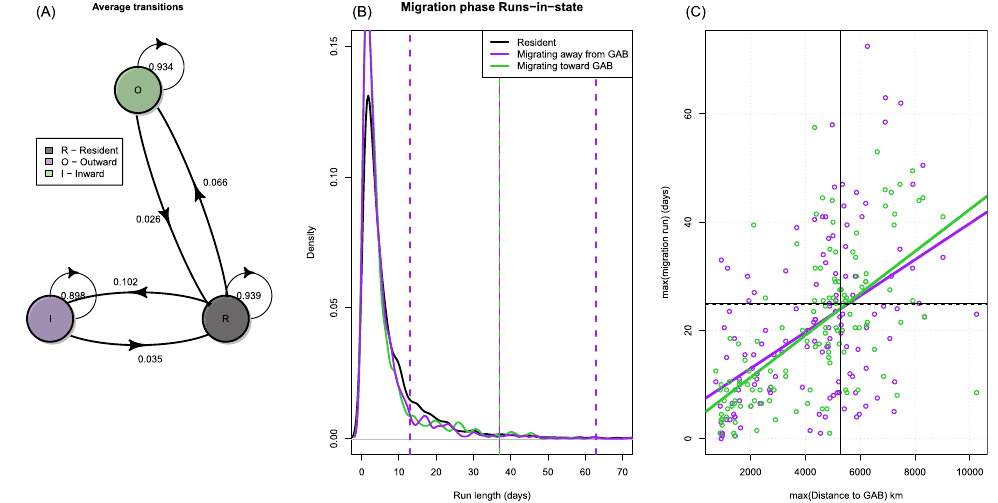
Figure 3. ( A ) Structure of the assumed Markov model chain for transitions between behavioural modes. Probabilities of transitions (arrows) label the transition between modes (circles). ( B ) Run lengths (lengths of runs in a single state) within behavioural modes when southern bluefin tuna were outside the Great Australian Bight (GAB). ( C ) Relationship between the time-in-migration mode and maximum distance from the GAB.